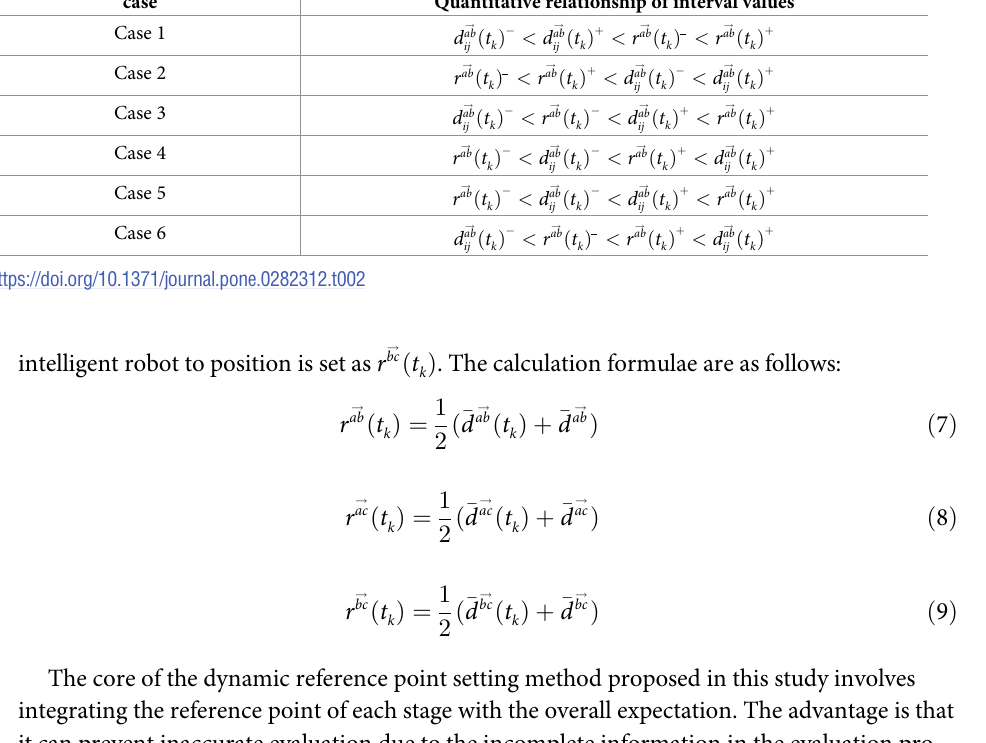
Table 2. Six quantitative relationships.